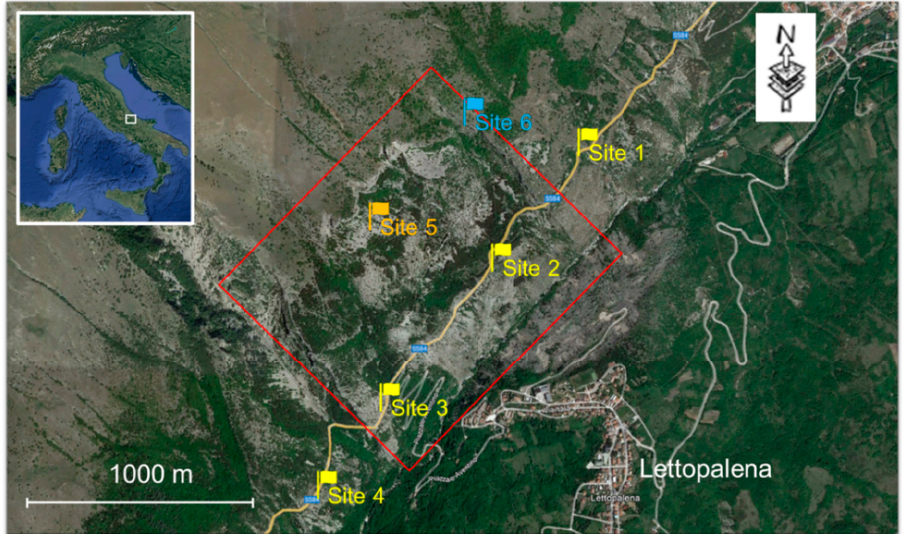
Figure 1. Location of the study area, showing the rough boundary of the analysed landslide (in red) and the sampling sites (site 1–4) of structural identification through traditional survey and UAV mapping, site 5 of structural identification using satellite mapping, and site 6 of topographic mapping.